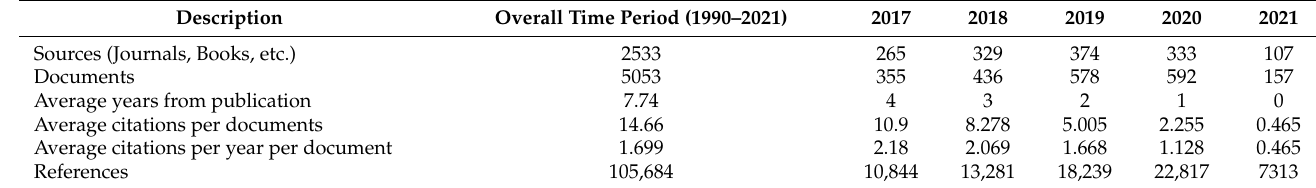
Table 1. Preliminary information about data, overall period, and per year.